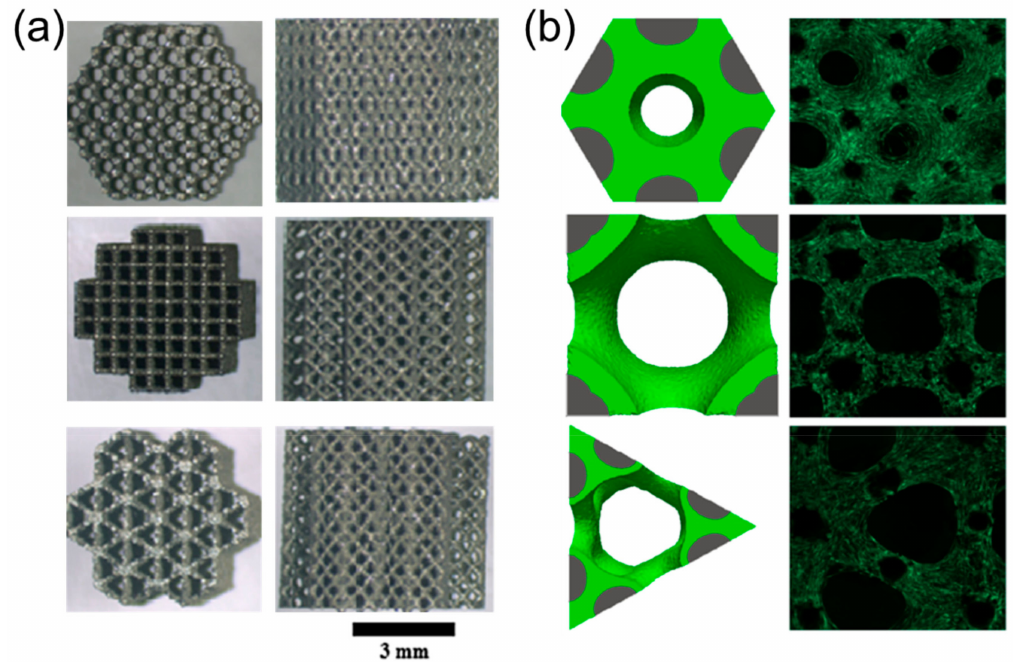
Figure 4. Sca ff olds with varied pore geometries ( a ) fabricated with titanium. ( b ) Tissue growth simulation and in vitro growth after 14 days. Images adapted with permission